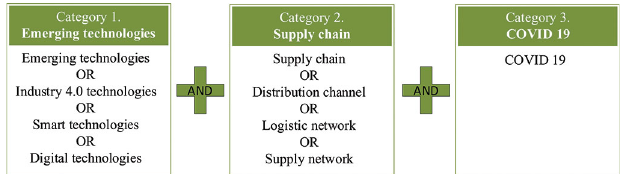
Figure 2. Categorical keywords for literature